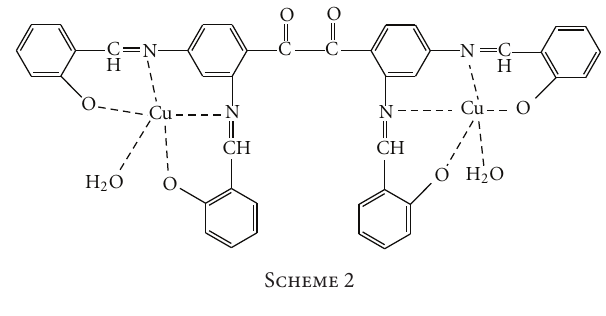
F 4: TGA curve of Cu(II)